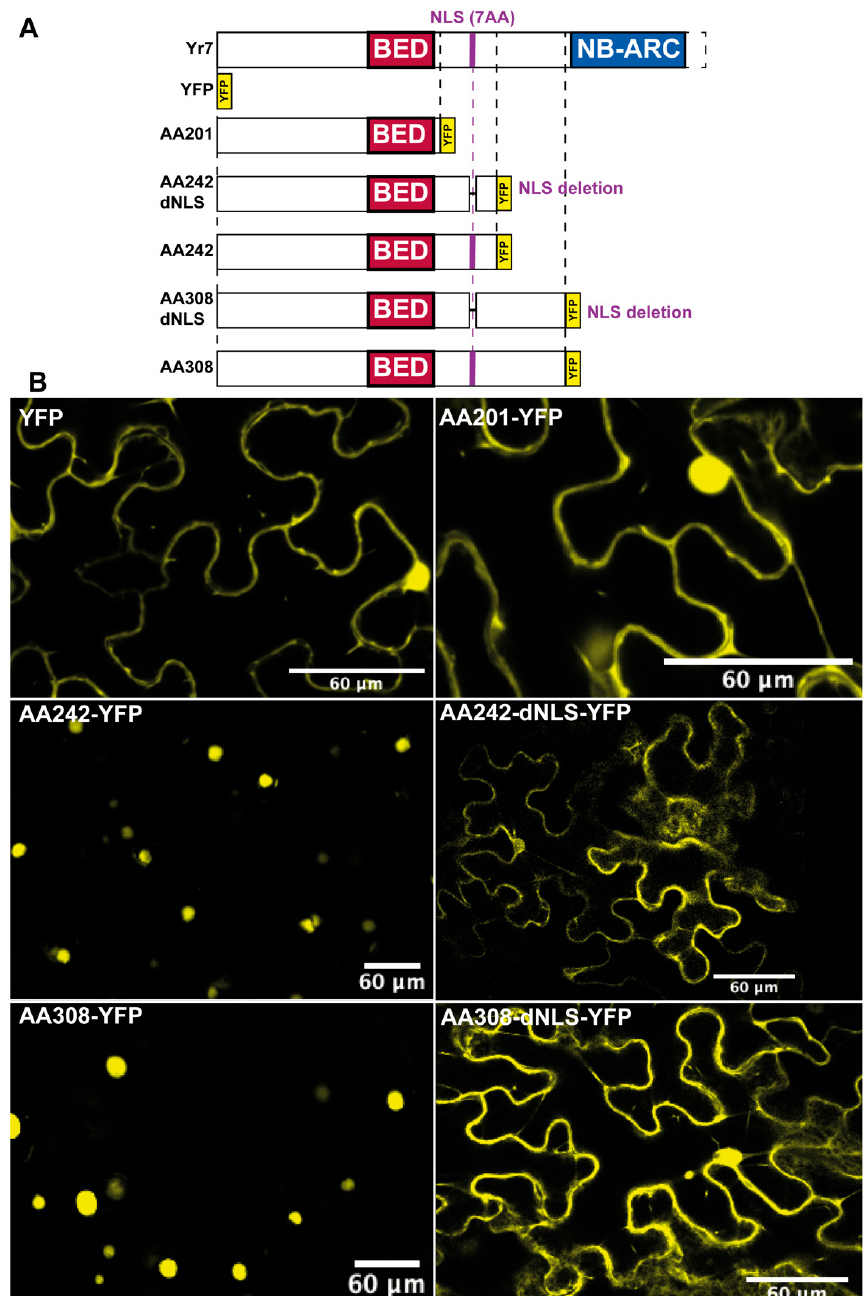
Figure 4. Cellular localization in N. benthamiana of truncated variants of the Yr7 protein and their corresponding deletion mutants in the predicted NLS. ( A ) Schematic describing the di ff erent truncations analysed and their corresponding deletion mutants in the predicted NLS (purple). Yr7-AA201 does not contain the predicted NLS. Both Yr7-AA242 and AA308 contain the predicted NLS whereas Yr7-AA242-dNLS and Yr7-AA308-dNLS are mutants lacking the predicted NLS. ( B ) Fluorescent microscopy pictures from leaves expressing the corresponding Yr7 variant. Samples were taken at 1.5 dpi and five leaf fragments from two leaves per plant (two plants per construct) were assessed under confocal microscope (see Methods section). Single YFP was used as a negative control.